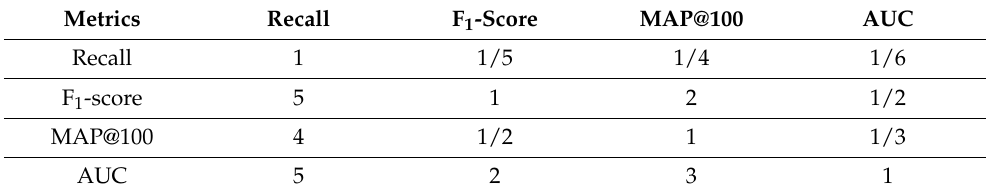
Table 4. The AHP method determines the classifier performance metric weight